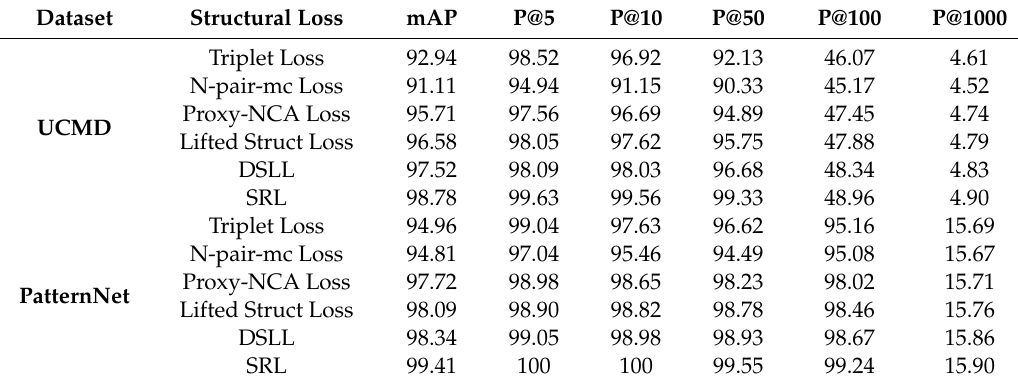
Table 1. The evaluation results of mAP and P@K on the PatternNet and UCMD database comparing with the other structure loss.